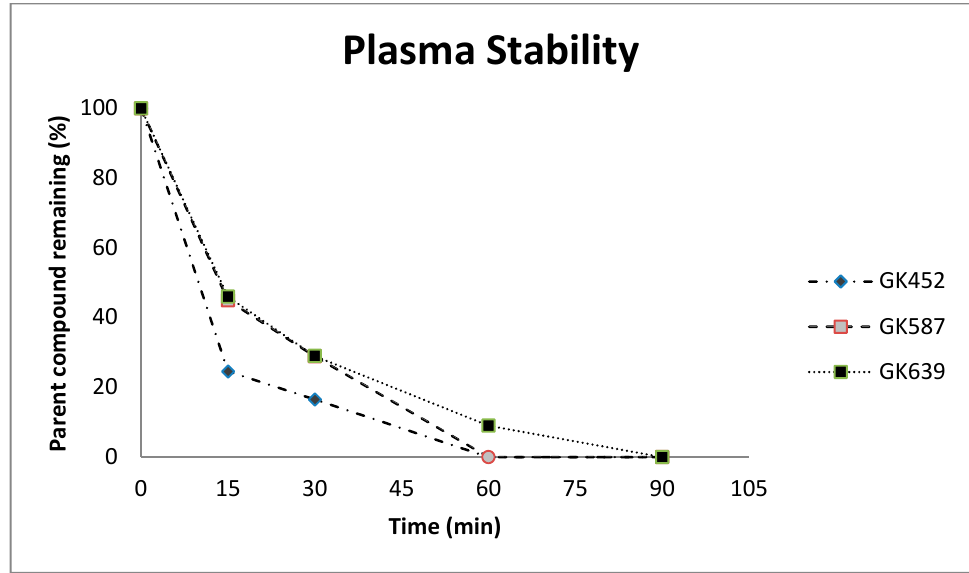
Figure 3. Plasma stability of GK587 and GK639 in comparison with GK452.